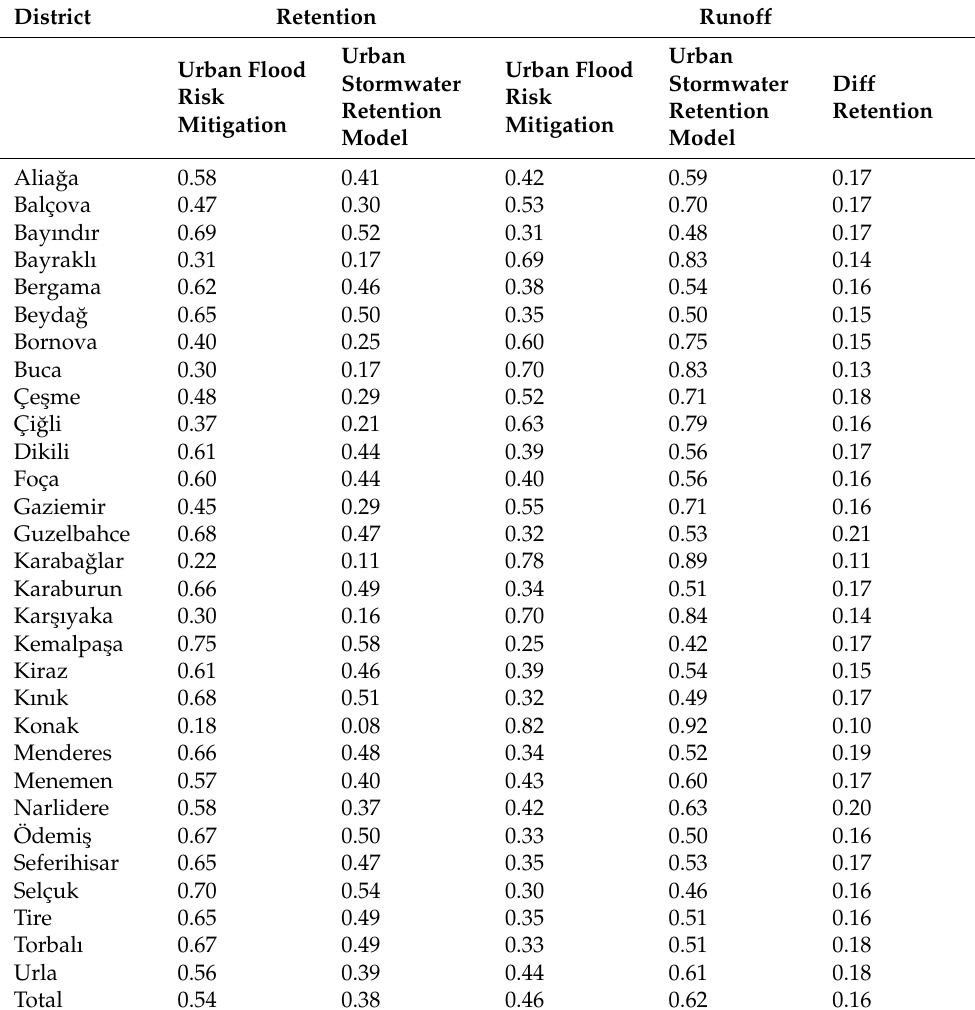
Table 6. Modeling results (relative values). Source: author’s elaboration on InVEST Output.